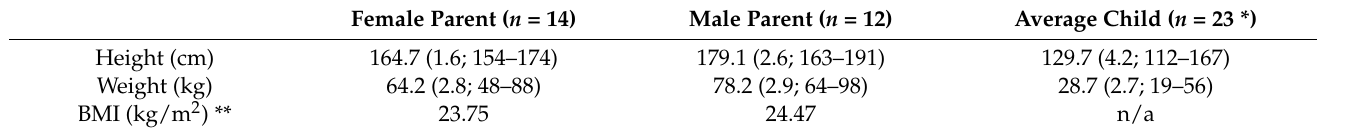
Table 1. Height and weight per family at one year follow-up (se;